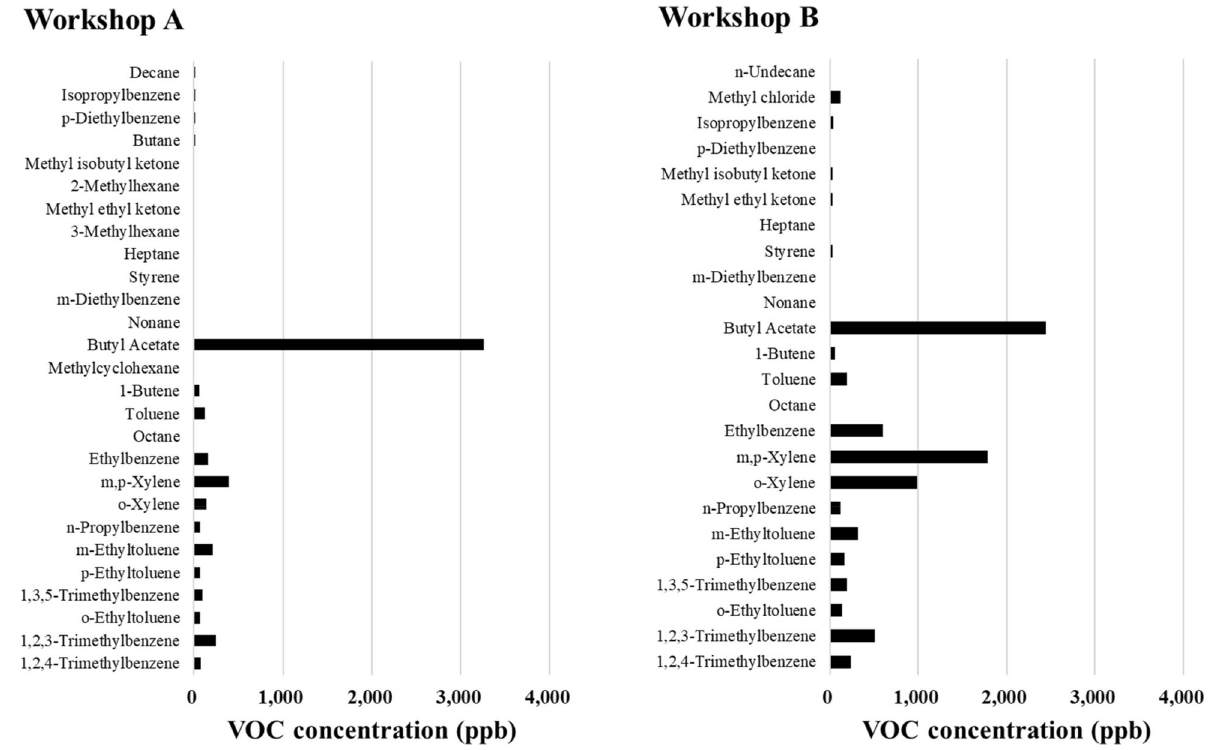
Figure 2. Concentration of volatile organic compounds (VOCs) emitted from workshops A and